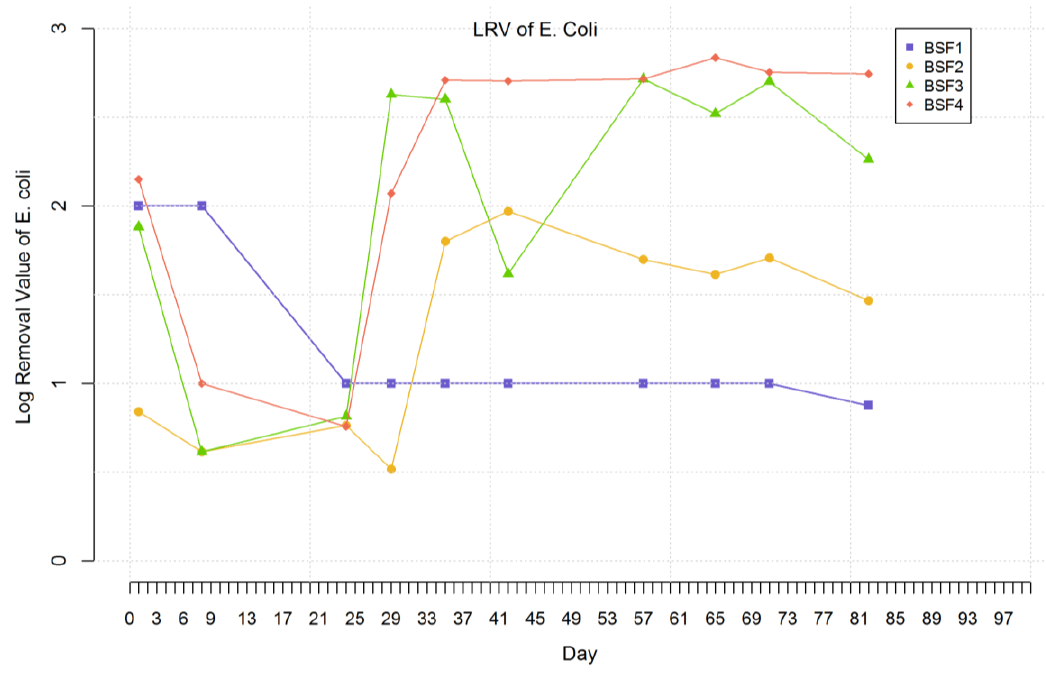
Figure 9. Log removal value of E. coli throughout the experiment.